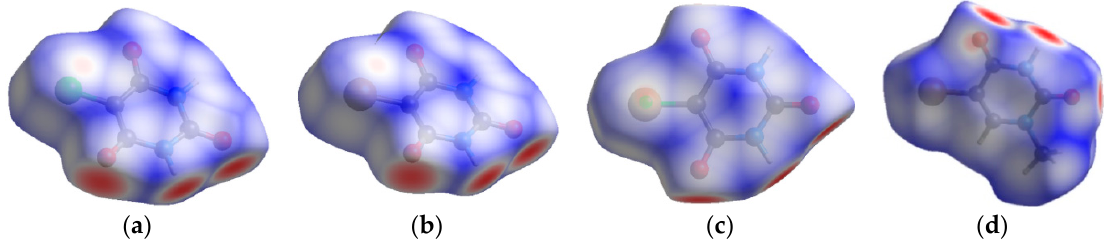
Figure 4. Hirshfeld surfaces mapped on d norm . ( a ) 5Clura; color scale: − 0.619 (red) − 0.922 a.u. (blue). ( b ) 5Brura; color scale: − 0.616 (red) − 0.950 a.u. (blue). ( c ) 5Cl5Brura; color scale: − 0.619 (red) − 0.973 a.u. (blue). ( d ) 5Br1Mura; color scale: − 0.601 (red) − 0.992 a.u. (blue).